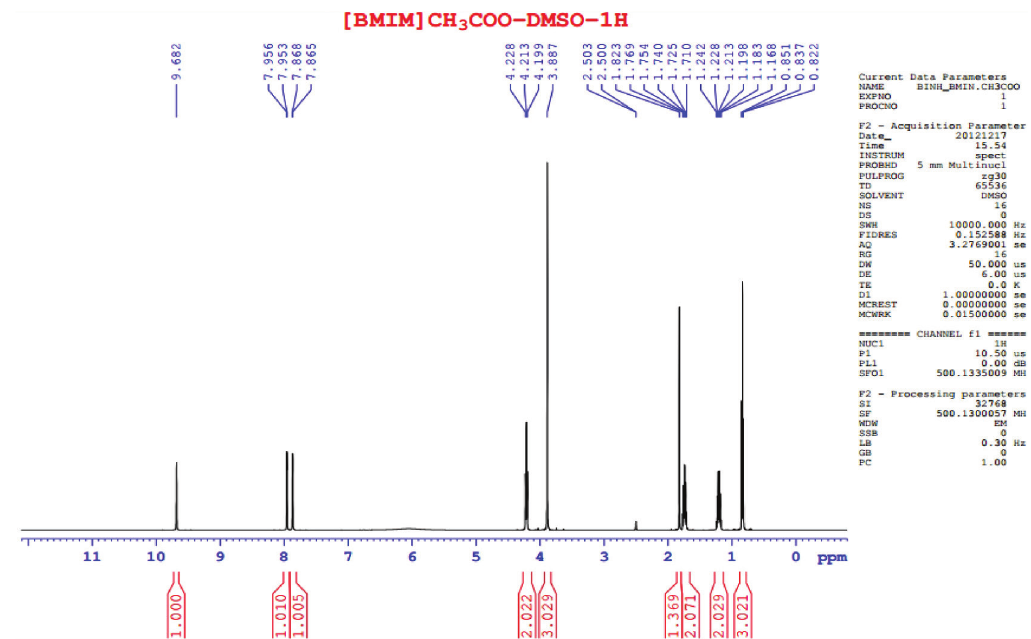
Fig. S5 – 1 H NMR spectra of [BMIM][CH